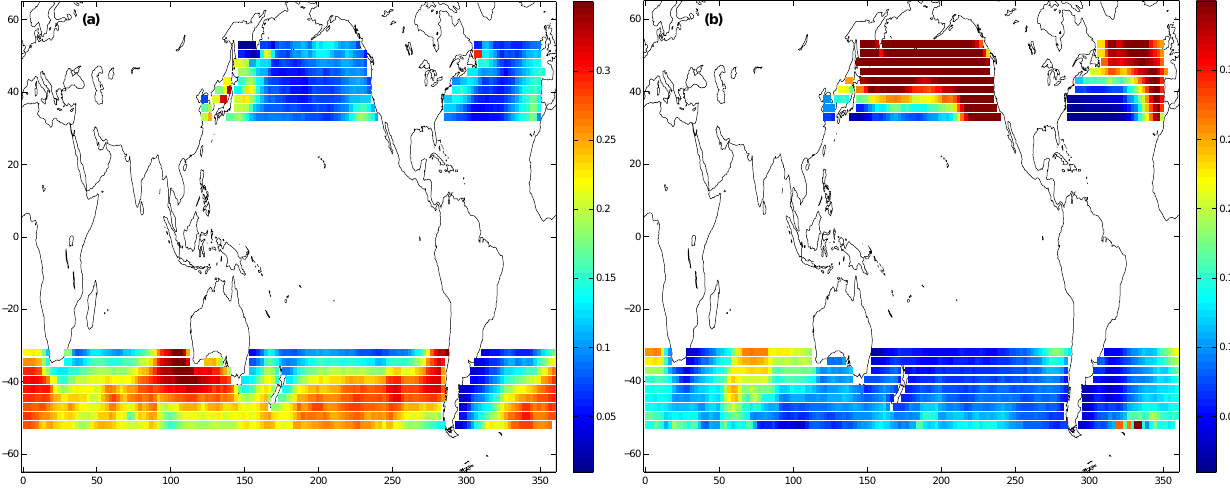
a large influence over midlatitude ocean cloudiness (Lau and Crane, 1995; Norris and Klein, 2000; Weaver and Ra- manathan, 1997), and Fig. 17 shows that vertical profiles of vertical velocity anomalies are almost exactly the same for warm and cold subsets. This result gives us confidence that our restriction of temperature advection to near-median val- ues successfully eliminated differences in the large-scale dy- namical forcing of clouds in the warm and cold subsets of each